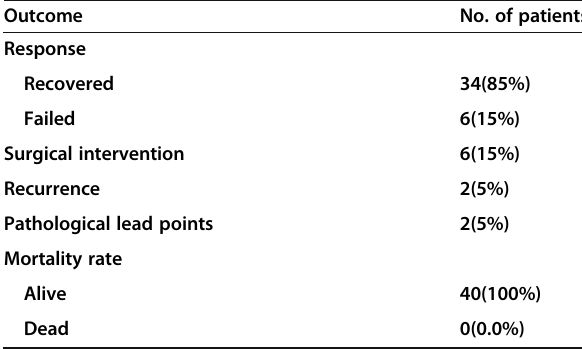
Table 4 The outcome of delayed repeated